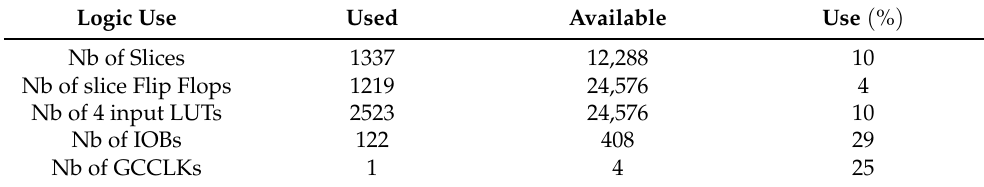
Table 3. Hardware resource utilization of the design (Multiplier with CORE